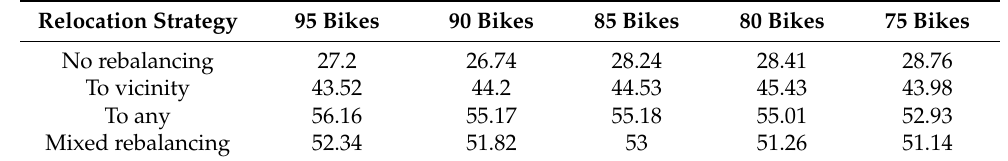
Table 3. Average mileage traveled per bike for the different rebalancing strategies with different fleet sizes (in km).